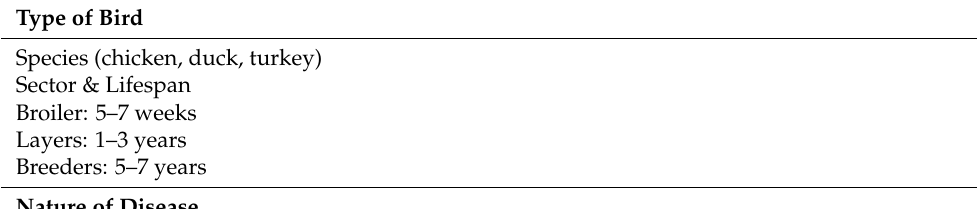
Table 1. Factors involved in the design, development and implementation of poultry